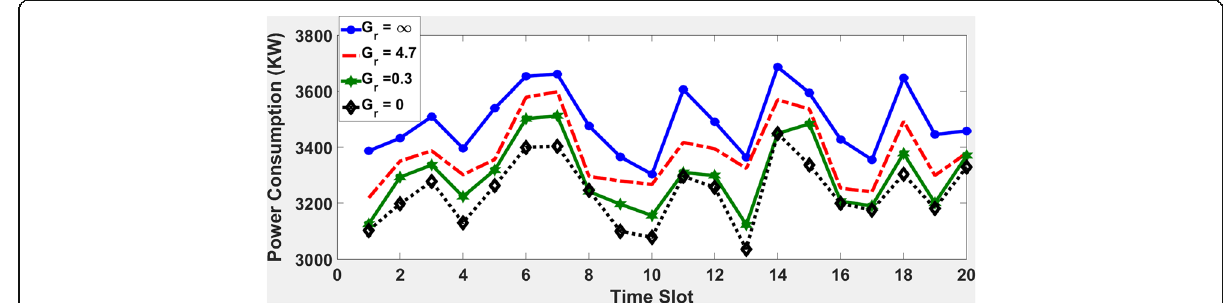
Fig. 3 Optimal power consumption as a function of time with migration cost G r as a